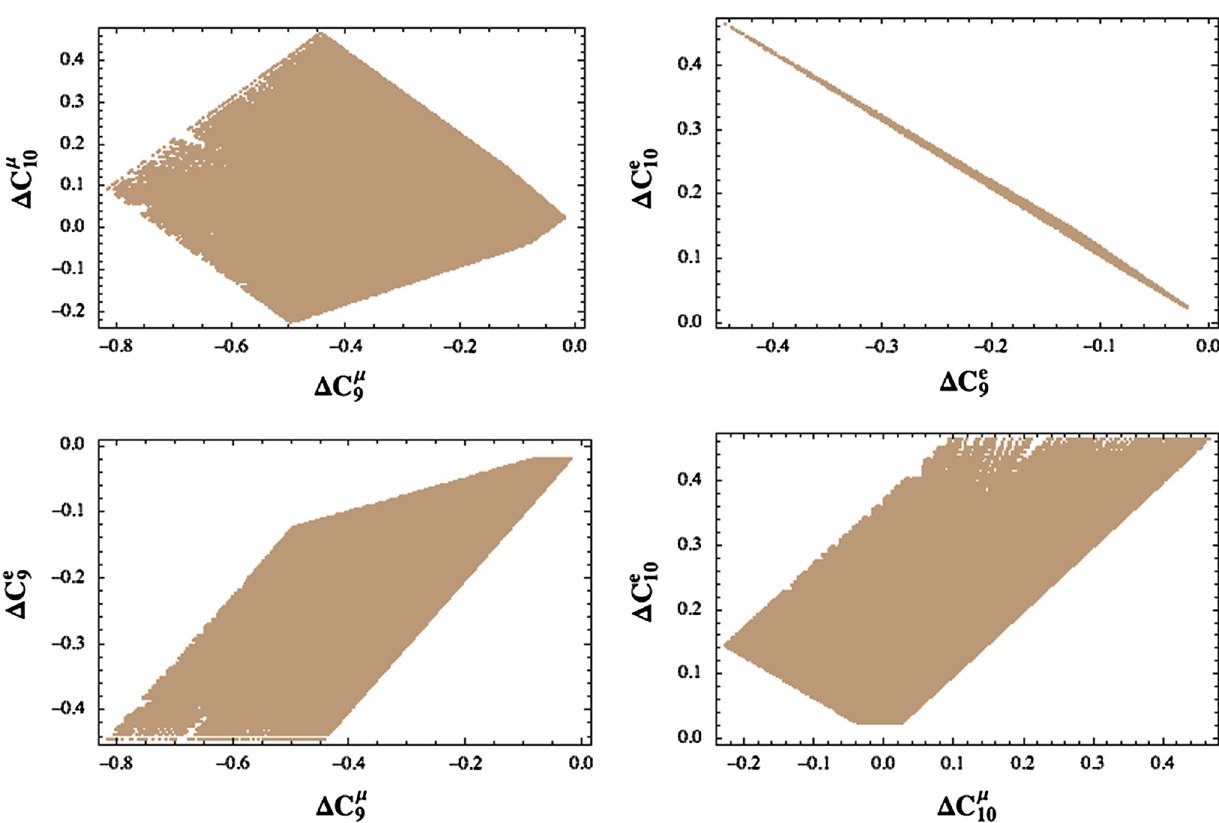
Fig. 4 Scenario A: plots gives the correlation in the C 9 and C 10 parameter plane for both the electron and the muon. We use M KK = 3 TeV μ with contributions mainly from (cid:8) C . The best fit for this 9 μ = − 1 . 5 with a 2 σ region [− 2 . 9 , − 1 . 73 case is (cid:8) C 9